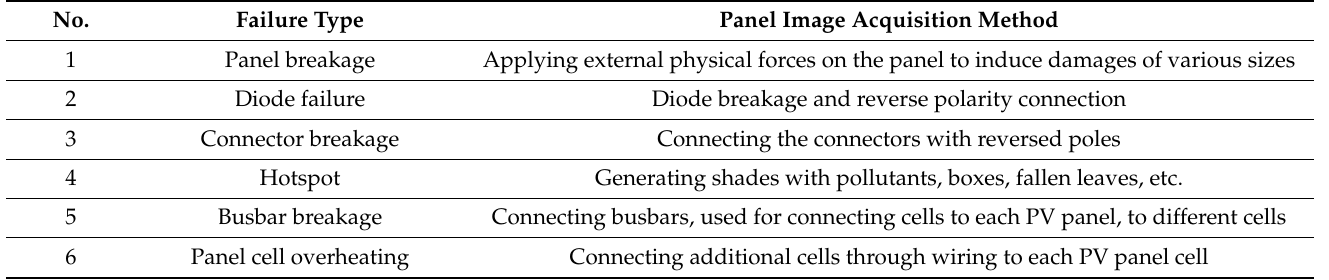
Table 3. Panel image acquisition method for different panel failure types. No.